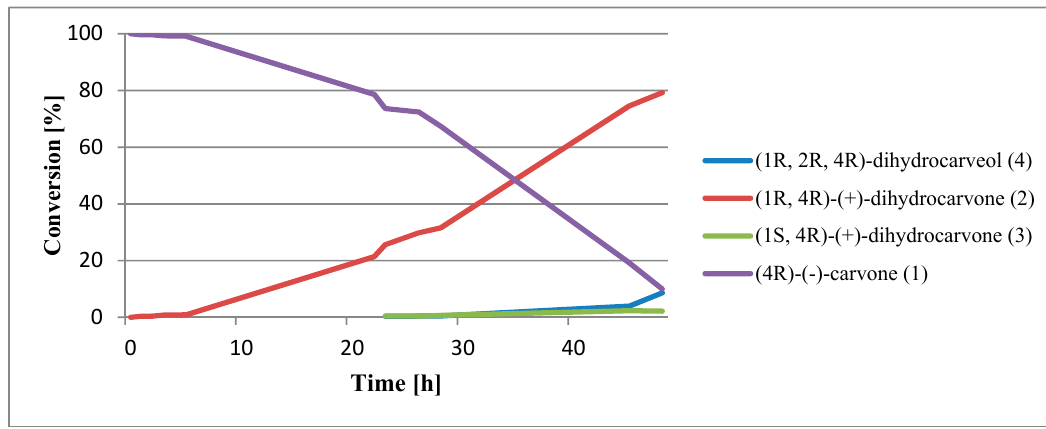
Figure 2. Biotransformation of 4 R )-(–)-carvone ( 1 ) via a comminuted potato.